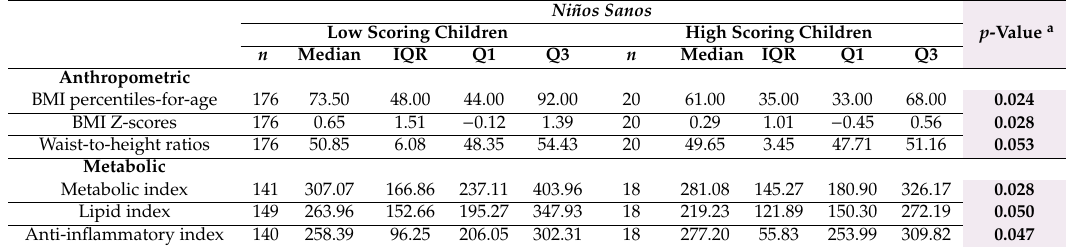
a . Kruskal Wallis. Bold text in left column show variable categories. Others without bold are variable sub-categories. p -values are shown in right-hand column in bold with light mauve shading.